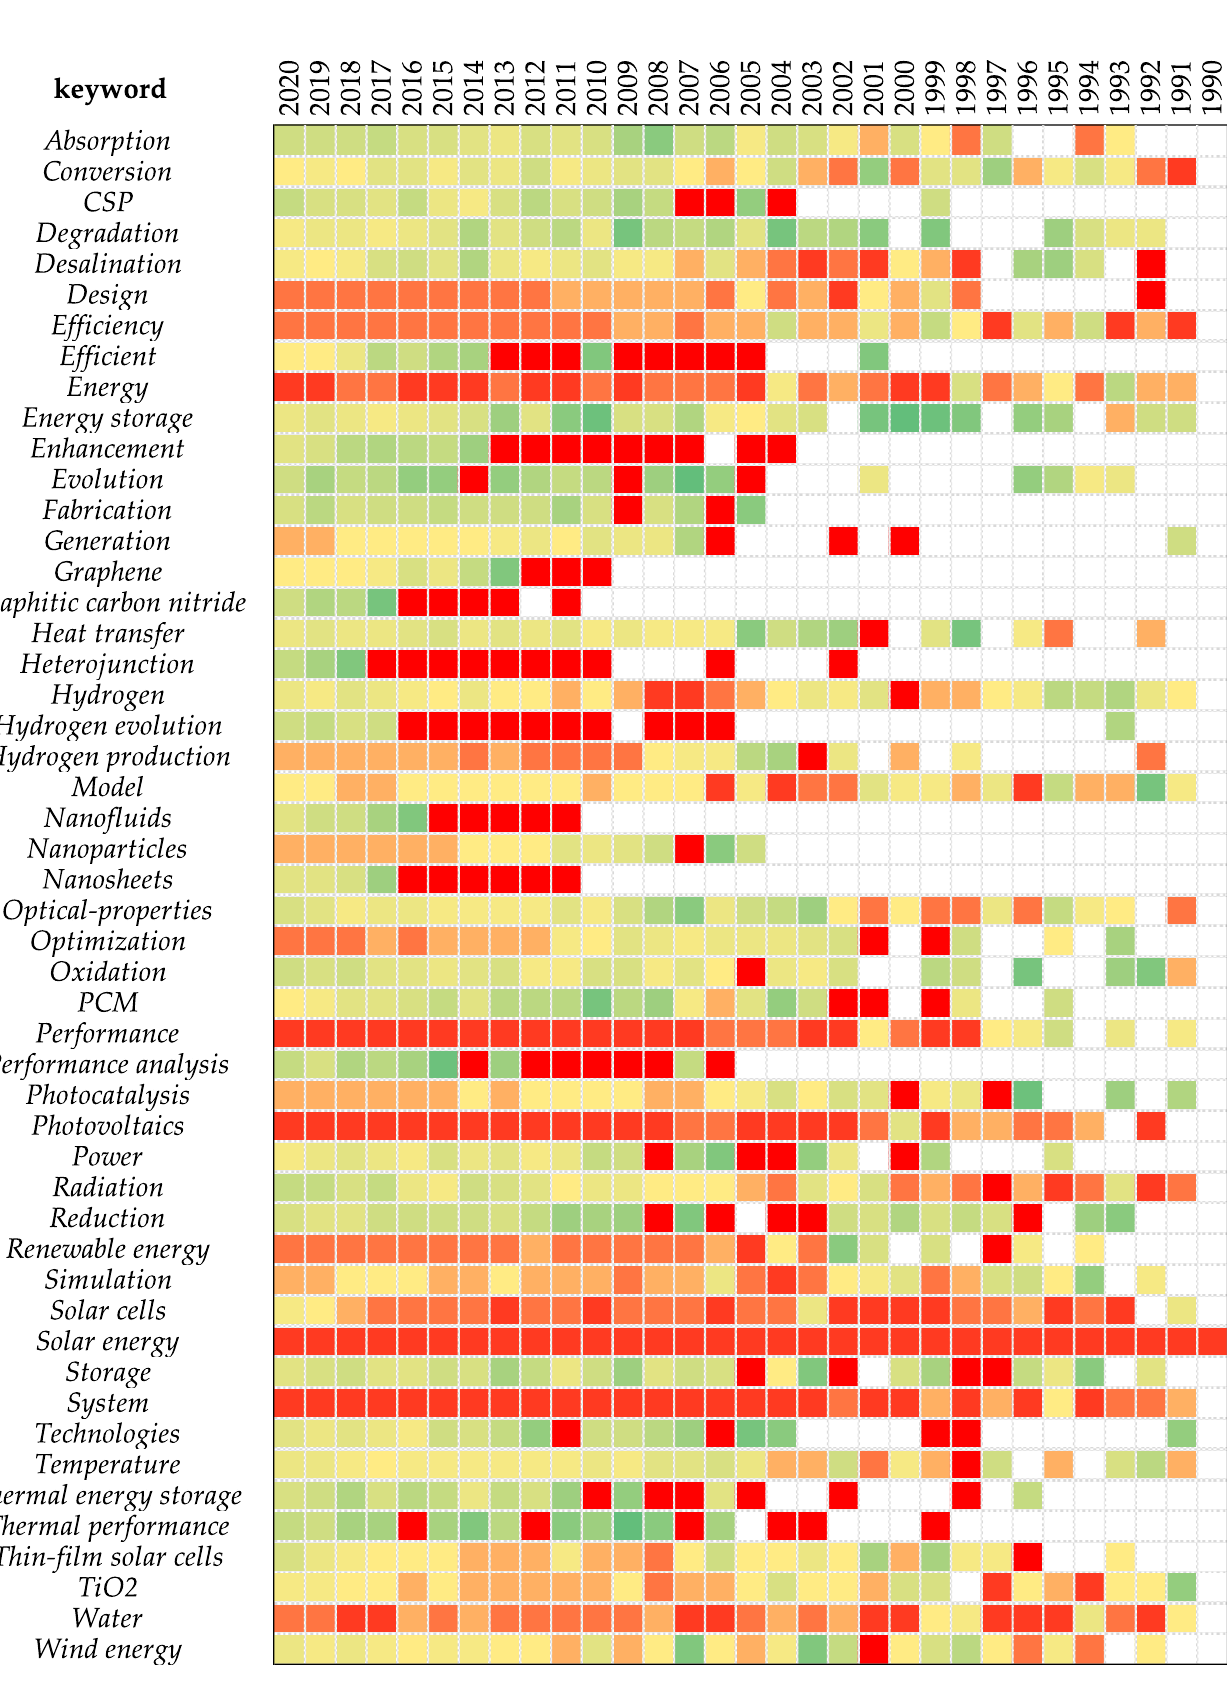
Figure 13. Evolution of 50 most common keywords of year 2020 within the period 1990–2020.